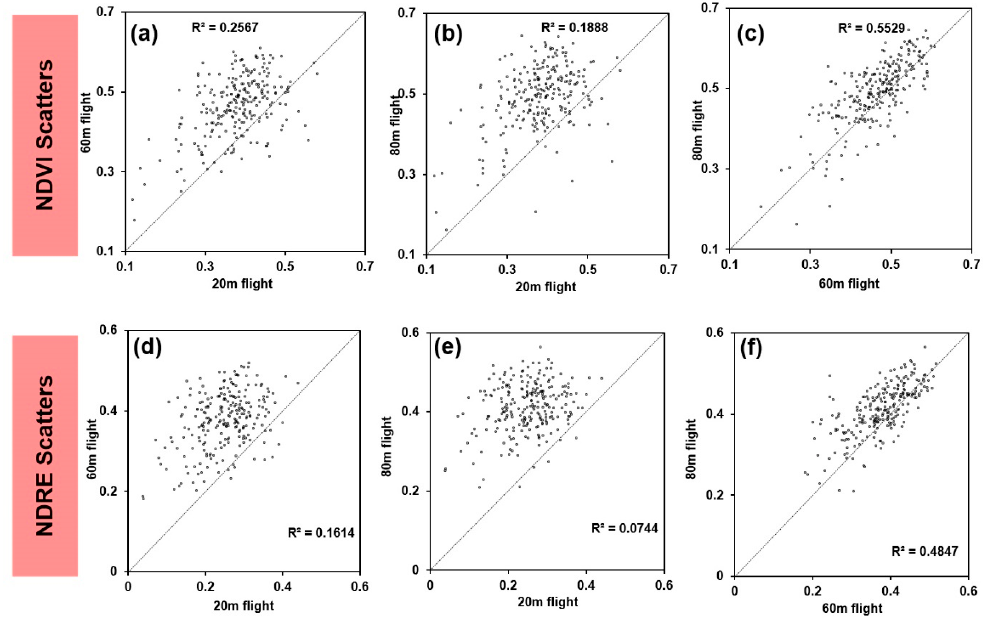
Figure 13. Scatterplot to compare NDVI and NDRE measured from different altitudes. Comparison between 20 m and 60 m ( a ) and ( d ), 20 m and 80 m ( b ) and ( e ), and 60 m and 80 m ( c ) and ( f ).